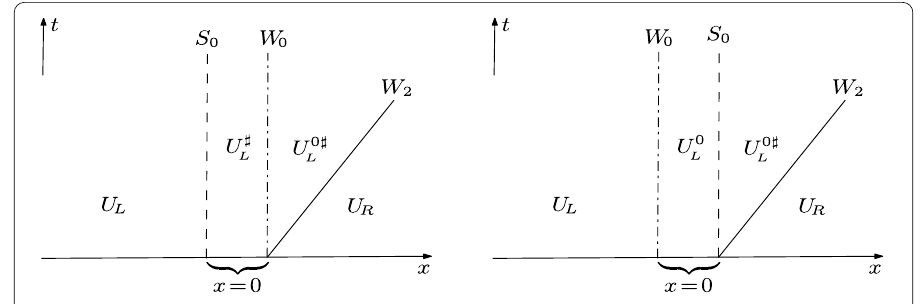
Figure 8 The Riemann solution at ( x , t ) space for subcases (A5)-(b) (left) and (A5)-(c) (right),